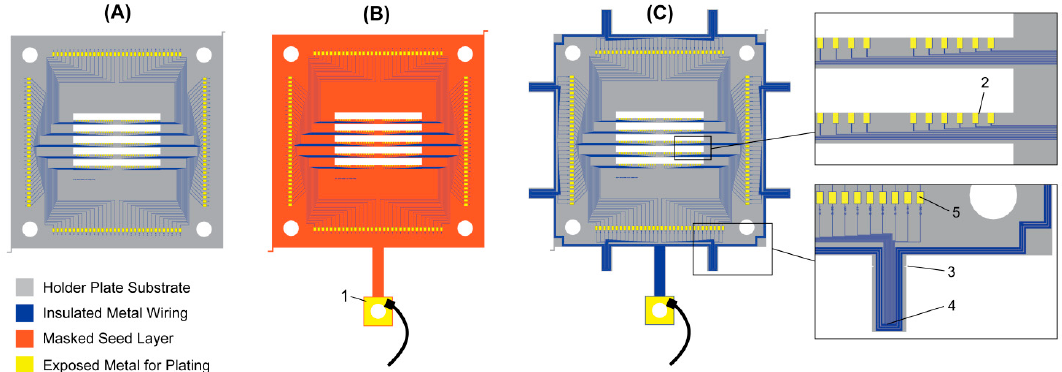
Figure 7. Layout illustrations for the different electroplating methods: ( A ) packaged and electroless plating, ( B ) seed and masked plating and ( C ) design with short-circuit beams. All cases aim to electroplate the small pads near the opening in the holder plate, shown as (2) but differ in how plating current is supplied to these pads. The larger external contact pads (5) can be plated as well,